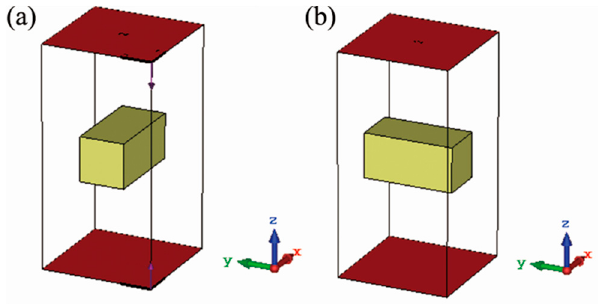
Figure 2. Simulation settings of the two single dielectric cuboids. ( a ) Cuboid 1. ( b ) Cuboid 2. The red facets are the receiving and the transmitting ports.